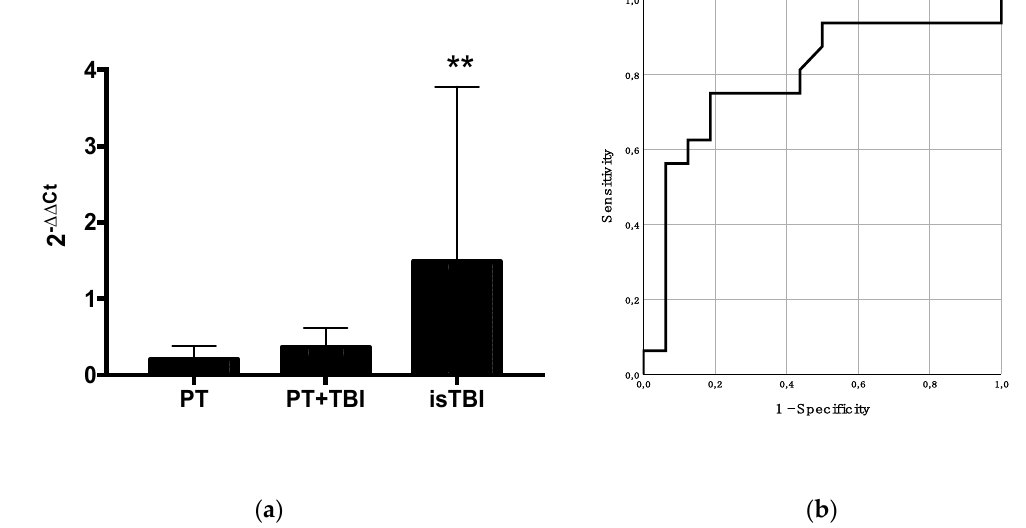
Figure 4. ( a ) Quantitative analysis of miR-423-3p stratified by injury pattern ( p -value < 0.01 = **) and ( b ) predictive power of miR-423-3p for severity of brain injury (AIS head ) in trauma patients (AUC: 0.79, p = 0.006, 95% CI: 0.62–0.96).